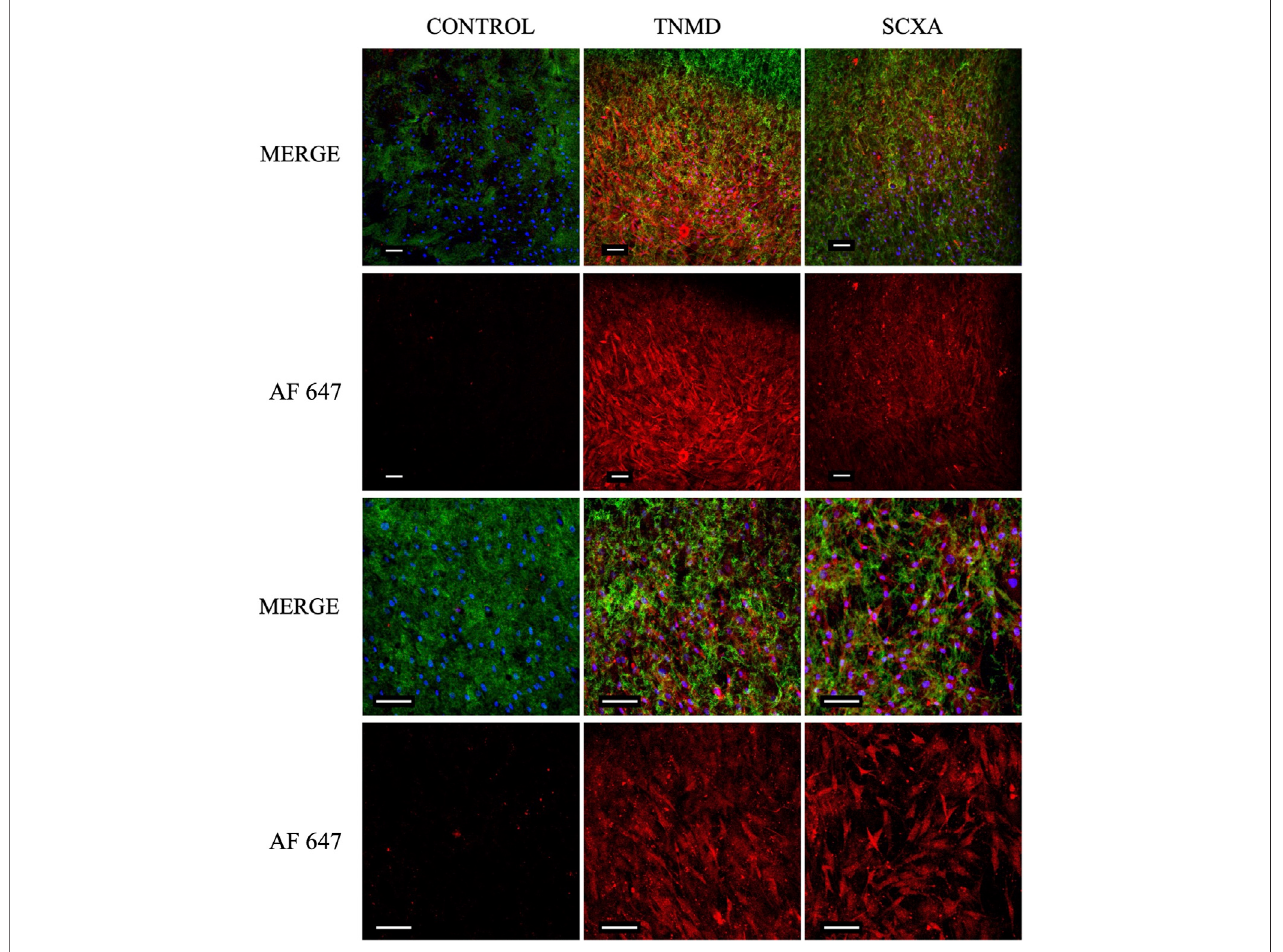
FIGURE 9 | Confocal images of cellular collagen I scaffolds 7 days post-gelation following fi xation and immuno fl uorescent staining for TNMD and SCXA. Expression of both proteins could be visualized in the experimental groups but not in the controls, indicating the tendon-like nature of the embedded cells. Scale bar = 100 μ m, magni fi cation = ×10 (rows 1 and 2), ×20 (rows 3 and 4). Blue = nuclei, green = collagen I, red = TNMD or SCXA (AF 647 = Alexa Fluor 647), and n = 3.